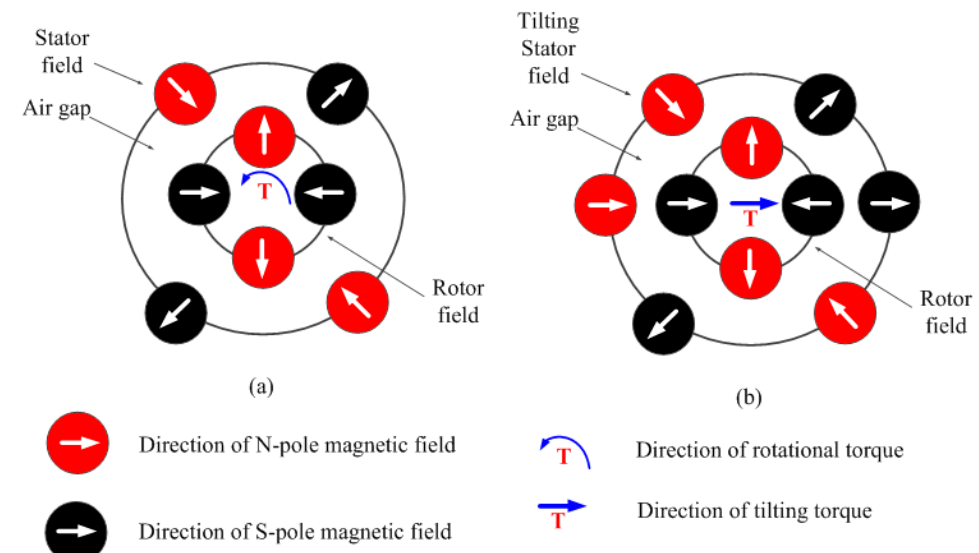
Figure 4. Motion model of permanent magnet deflection type 3-DOF motor. ( a ) Rotation model and ( b ) deflection model.